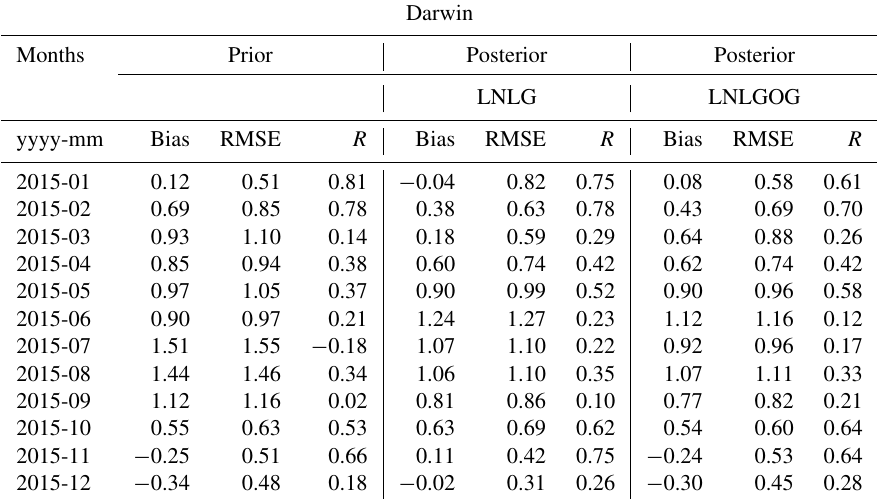
Table G1. Analysis of the residual between CMAQ prior and posterior simulations and the TCCON Darwin site for 2015: averaged bias, RMSE and Pearson’s coefficient ( R